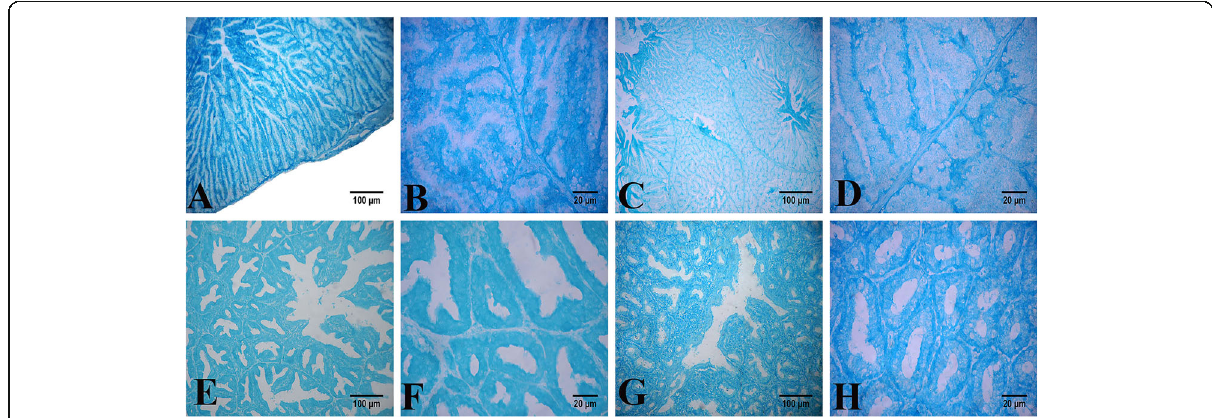
Fig. 13 Light micrograph of the HG of duck ( A , B ), goose ( C , D ), ibis ( E , F ), and pigeon ( G , H ). Positive reaction in centrally located cells of ducts and the glandular epithelium of secretory units with alcian blue. Stain, alcian blue pH